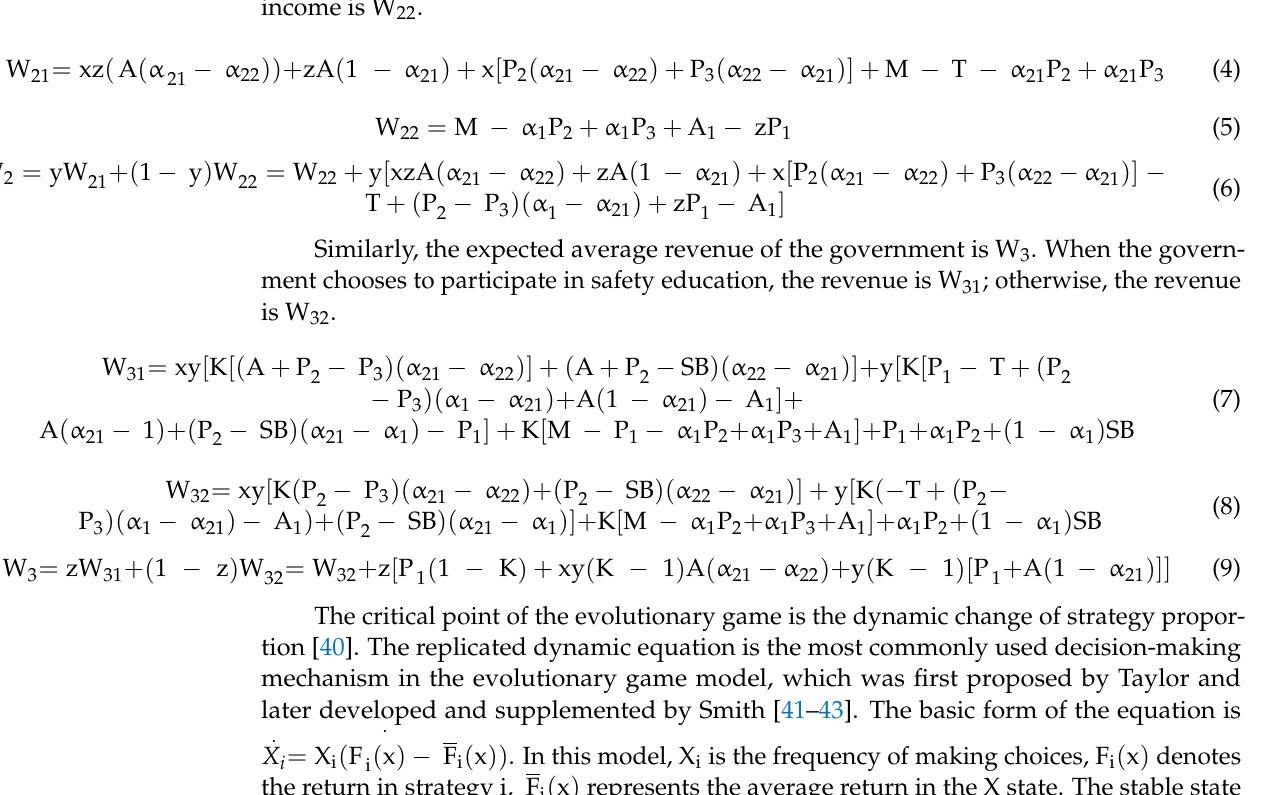
Attachment: The first formula in the cell represents the income of construction workers, the second formula represents the income of construction units, and the third formula represents the government